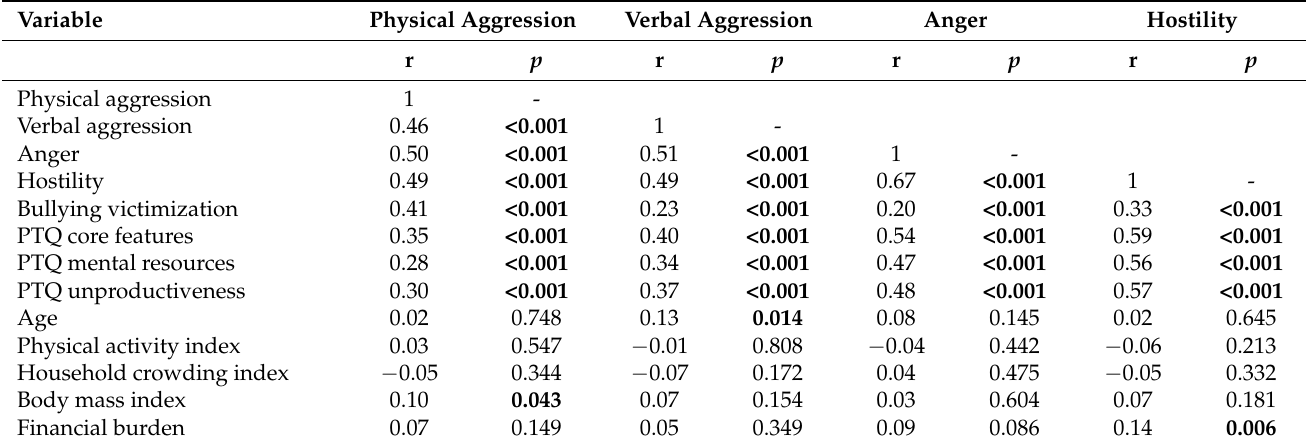
Table 3. Bivariate analysis of the continuous variables associated with the aggression scores.